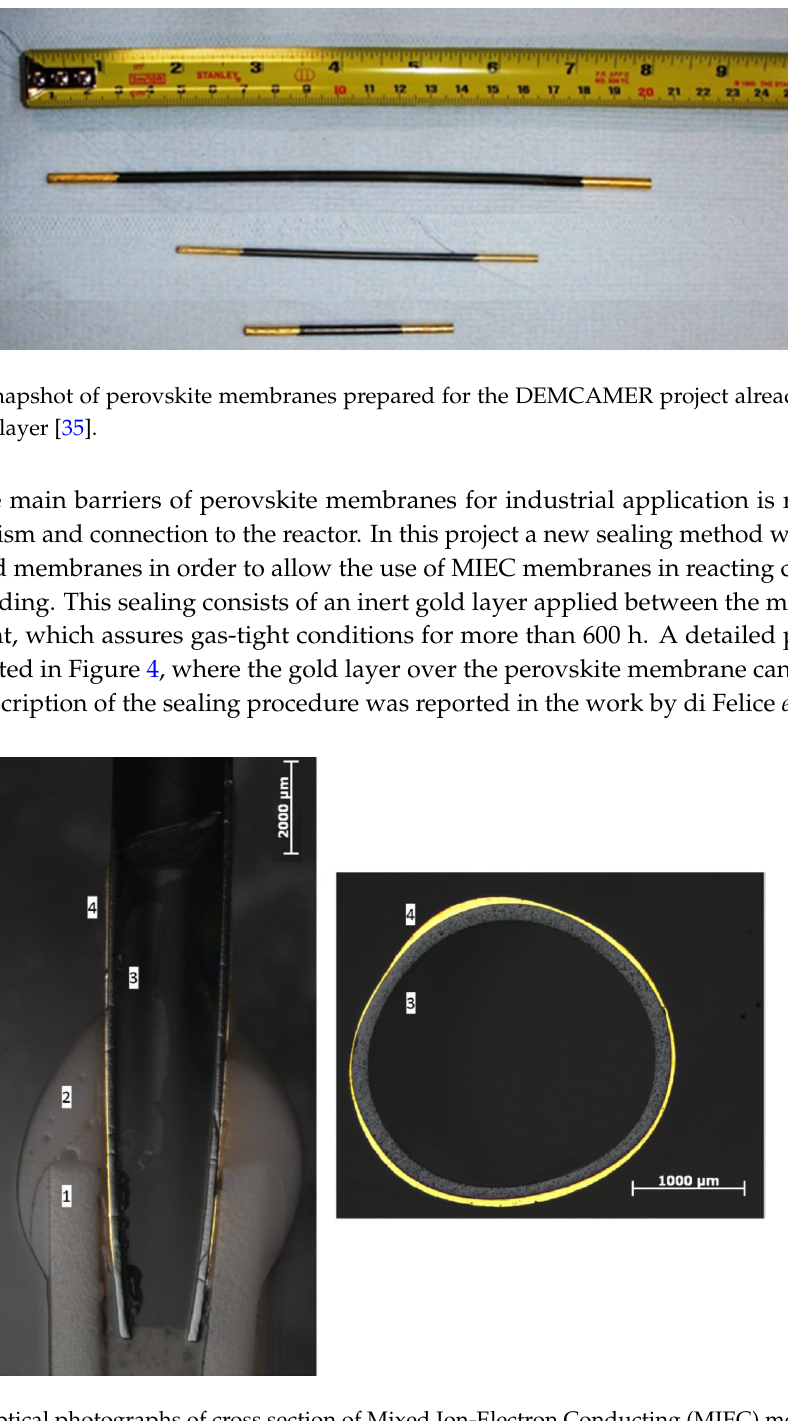
Figure 4. Optical photographs of cross section of Mixed Ion-Electron Conducting (MIEC) membranes sealed with gold [35]. ( 1 ) Al 2 O 3 tubes; ( 2 ) glass seal; ( 3 ) membrane wall; ( 4 ) gold coating.